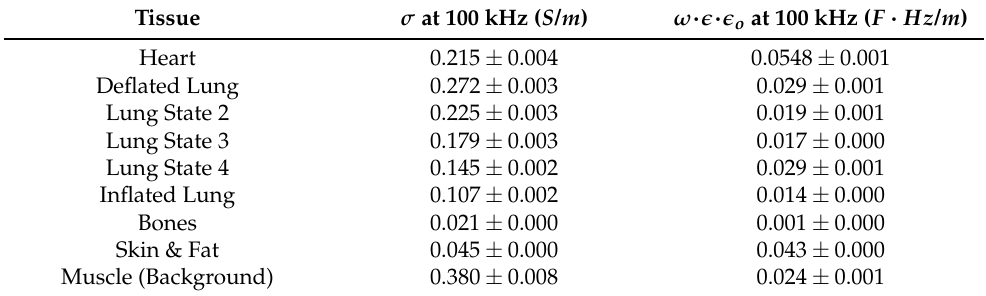
Table 1. Assigned conductivity and permittivity values to the thoracic models’ tissues for f = 100 kHz, according to [47–49], and (41)–(42). The admittance is estimated as γ = σ + j ω(cid:101)(cid:101) o .